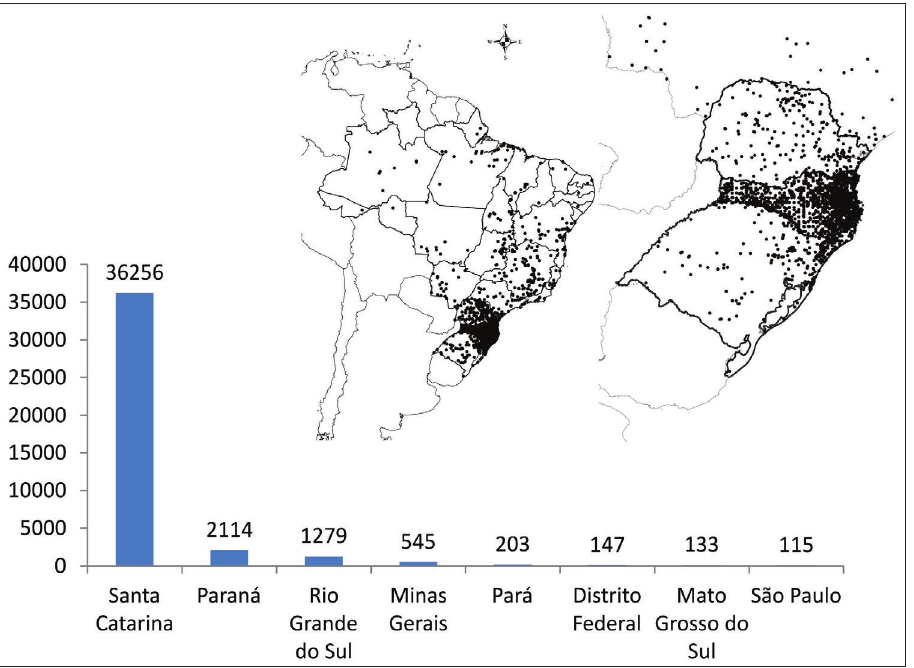
Figure 4. Spatial coverage of FURB collection. Only the hundred best states